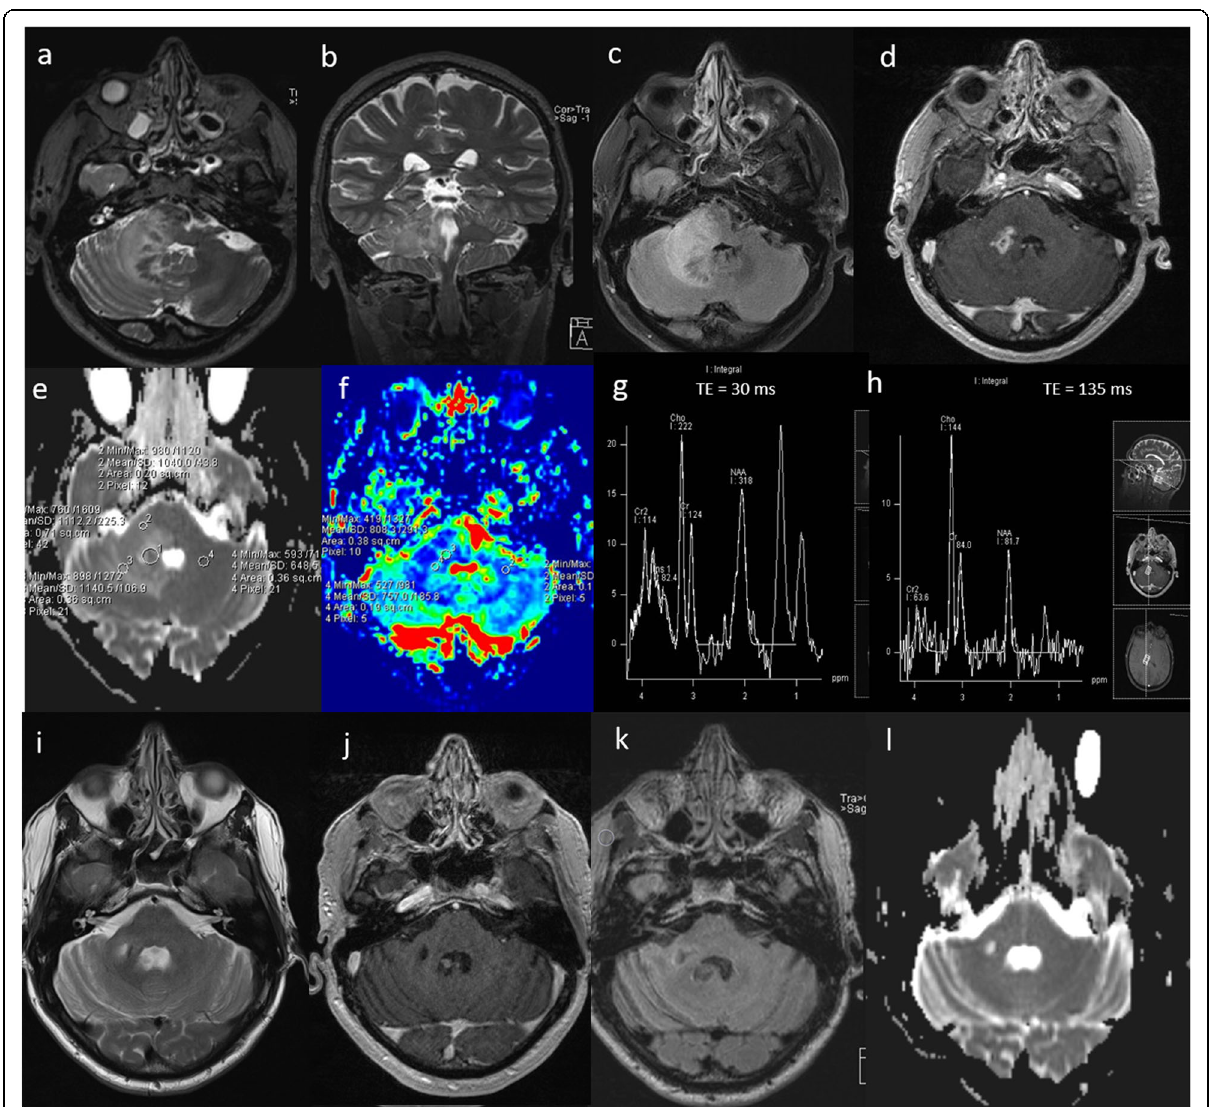
Fig. 14 Neurosarcoidosis. Known case of systemic sarcoidosis. Conventional MRI Findings: a , b Axial and coronal T2W, ( c ) axial FLAIR and ( d ) post- contrast T1W sequences, showing a diffuse infiltrative lesion with enhancing foci in the right cerebellar peduncle extending to the brainstem, mimicking tumour. Multiparametric MRI: e DWI shows focal areas of low ADC. f PWI shows low perfusion in comparison to the contralateral side. g MRS with a short TE (30 ms) shows moderately high Cho/Cr ratio (< 2), near normal NAA/Cr and mI/Cr, presence of glutamate and glutamine at 2.4 – 2.6 ppm and large lipid peaks at 0.9 and 1.3 ppm suggesting necrosis. h MRS with a TE 135 ms shows slightly low NAA/creatine ratio and absence of lactate. In this case, the findings of low perfusion (< 2), absence of a lactate peak and presence of glutamine and glutamate favour an inflammatory aetiology such as neurosarcoidosis rather than a high-grade glioma. A tapering dose of oral prednisolone was commenced, during which neurological symptoms improved. Three-month follow-up MRI; ( i ) axial T2W, ( j ) post-contrast T1W, ( k ) FLAIR and ( l ) ADC sequences show near complete resolution of the lesion after treatment with